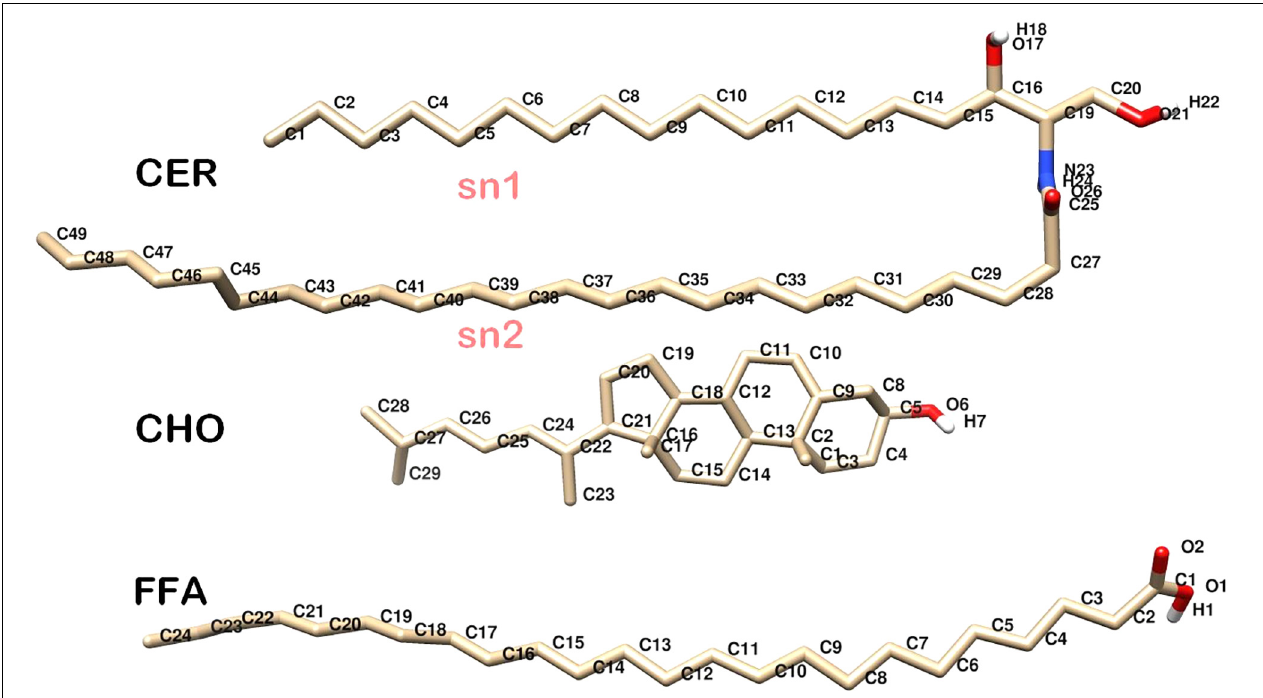
FIGURE 1 | Molecular structure of individual skin lipids used in simulations. CER, Ceramide NS; CHO, Cholesterol; FFA, Free Fatty Acid. Oxygen, Hydrogen, Carbon, and Nitrogen atoms are shown in red, white, gray, and blue color,